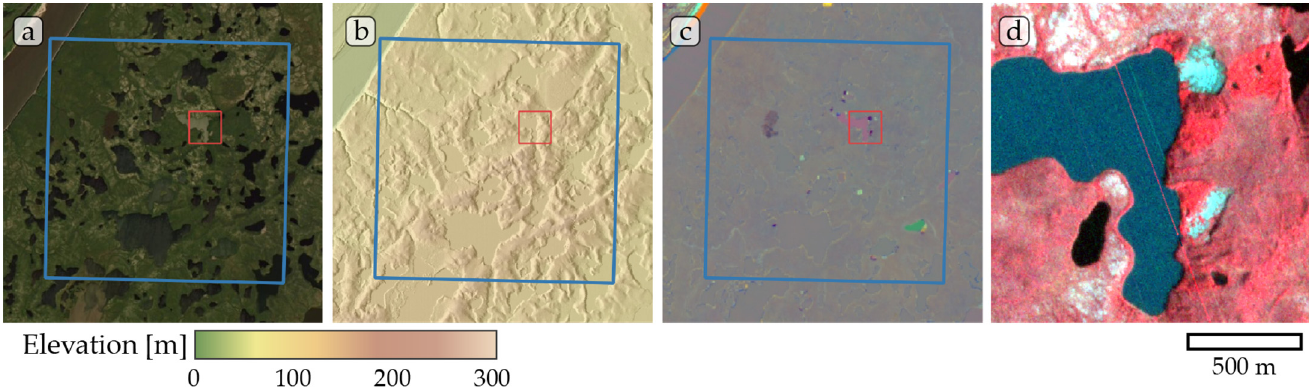
Figure A9. Study site Tuktoyaktuk. ( a ) ESRI satellite layer, ( b ) ArcticDEM superimposed with hillshade, ( c ) Tasseled Cap trend visualization, ( d ) PlanetScope satellite image (NIR-R-G) acquired on 13 July 2019. Blue box, 10 × 10 km study site. Red box detailed view of ( d ). Figure A10. Mean and standard deviation of IoU scores per encoder sorted by ( a ) epoch and by ( b ) scores (best to worst). n = 18 (6 sites × 3 architectures) per encoder. References 1. Box, J.E.; Colgan, W.T.; Christensen, T.R.; Schmidt, N.M.; Lund, M.; Parmentier, F.-J.W.; Brown, R.; Bhatt, U.S.; Euskirchen, E.S.; Romanovsky, V.E.; et al. Key Indicators of Arctic Climate Change: 1971–2017. Environ. Res. Lett. 2019 , 14 , 045010, doi:10.1088/1748-9326/aafc1b.